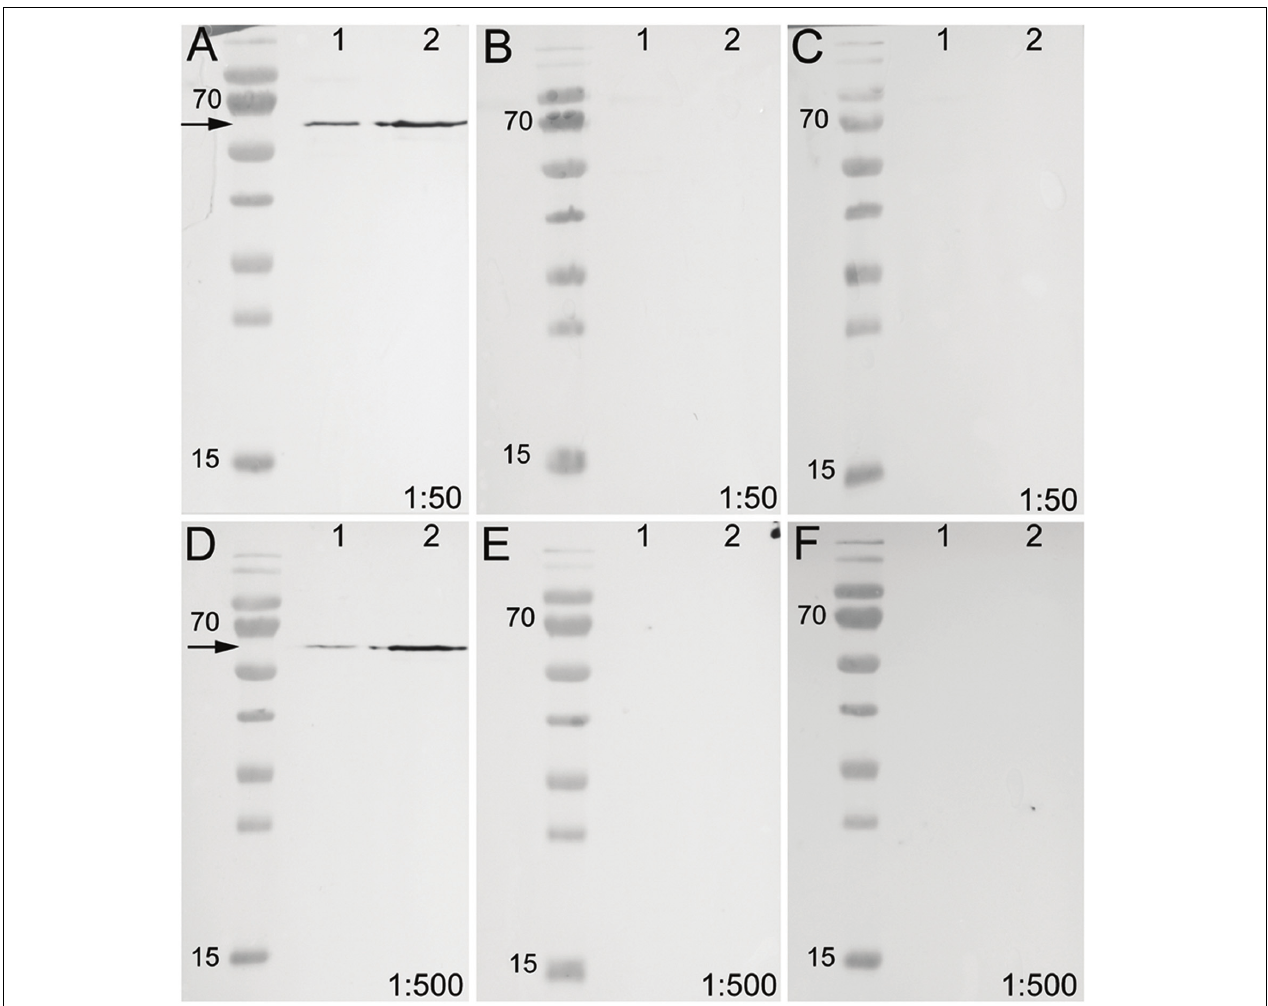
FIGURE 7 | Western blot of unblocked and blocked arthropsin antisera using recombinant expressed protein extracted from Escherichia coli . Truncated Er-arthropsin (20 kDa) fused with MBP (42,5 kDa) was used for all experiments. Lane 1 was loaded with the bacterial cell lysate of Escherichia coli and lane 2 with the purified Er-arthropsin-MBP fusion protein in all images. (A) Unblocked anti-arthropsin antibody (dilution 1:50). Note the two distinct bands at 63 kDa (arrow). (B) Blocked antibody with twice (2x) the amount of the synthetic peptide (1:50). (C) Blocked antibody with 10-fold (10x) the amount of the synthetic peptide. (D) Unblocked anti-arthropsin antibody (1:500). Note the two distinct bands at 63 kDa (arrow). (E) Blocked antibody with twice (2x) the amount of the synthetic peptide (1:500). (F) Blocked antibody with 10-fold (10x) the amount of the synthetic peptide (1:500). Note the absence of specific bands in all experiments with blocked anti-arthropsin antibody (B,C,E,F)